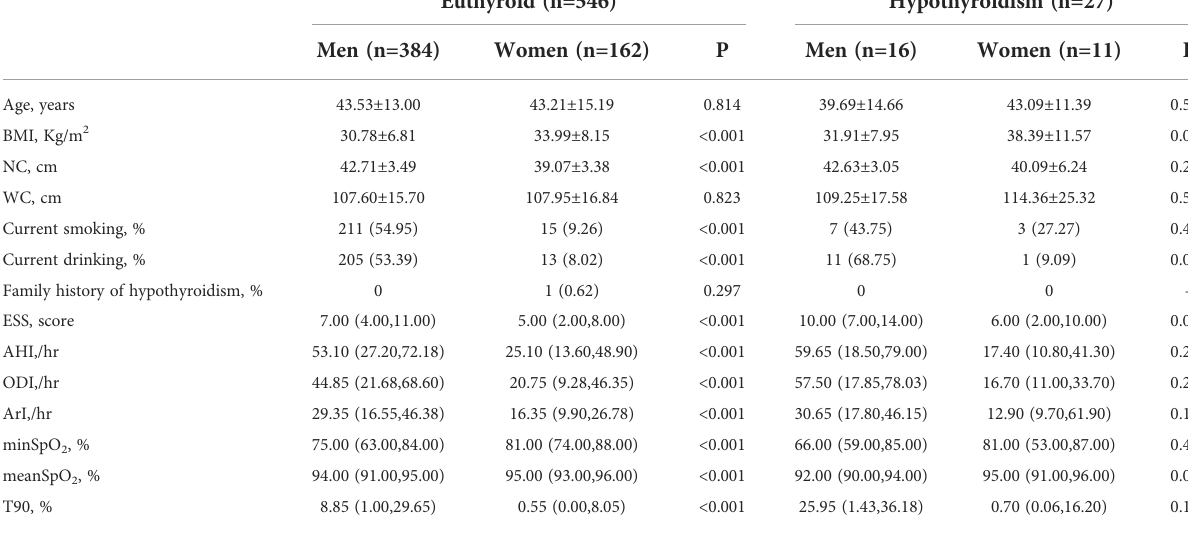
TABLE 1 Gender differences in OSA patients with euthyroid or